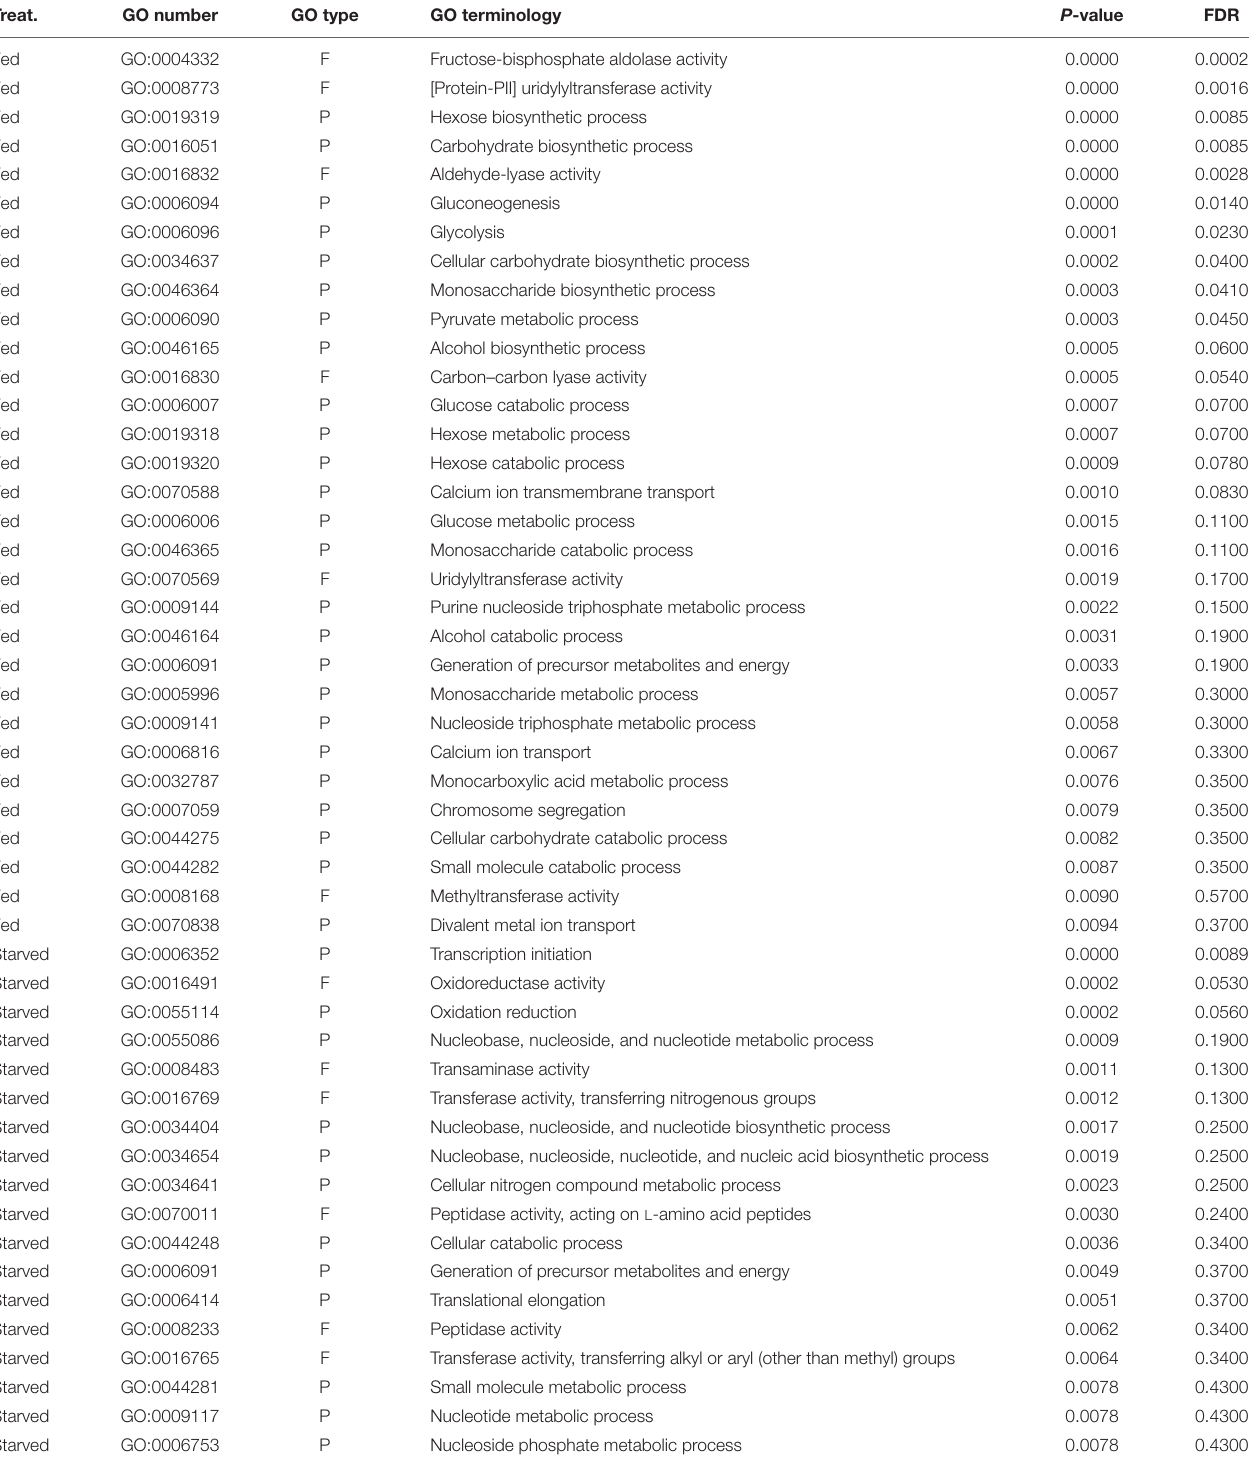
TABLE 6 | Result of the GO enrichment analysis based on the RNA-Seq derived 1576 significantly differentially expressed transcripts found in O. marina cells subjected to two culture treatments: feeding and starvation.